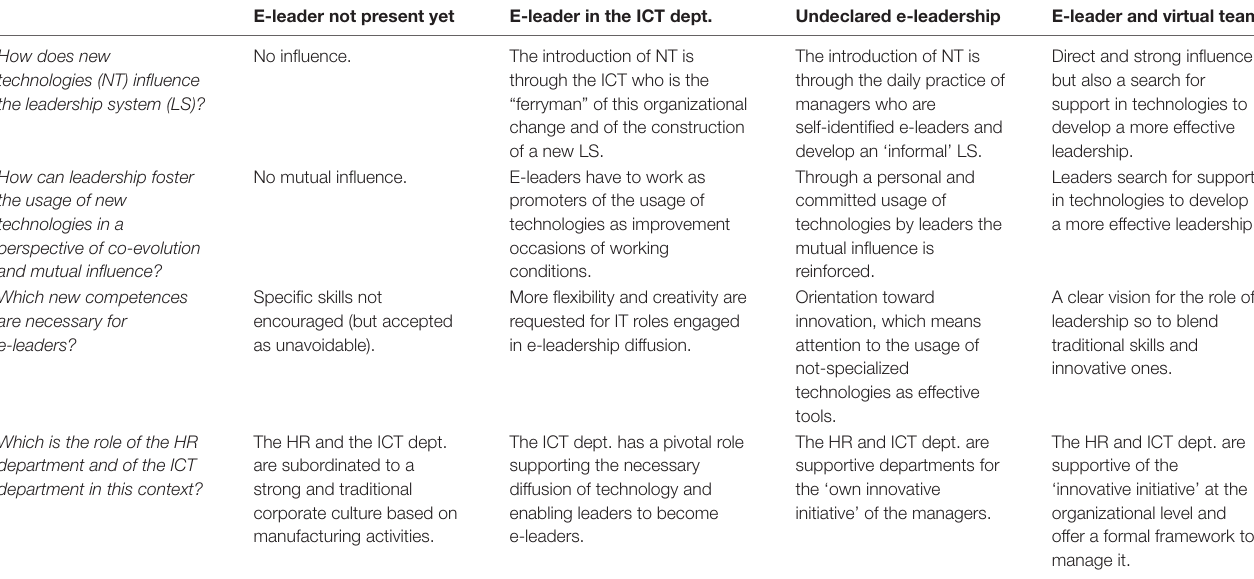
TABLE 3 | The different features of the four typologies of